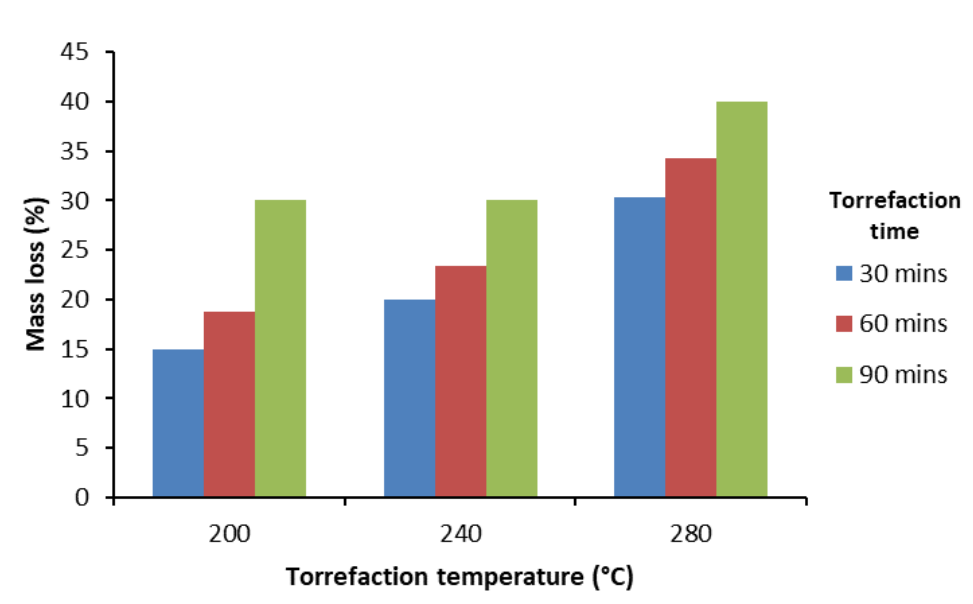
Figure 2. Mass loss during torrefaction of corncobs. Table 2. Results of grinding throughput, proximate analyses, and energy yield of raw and torrefied